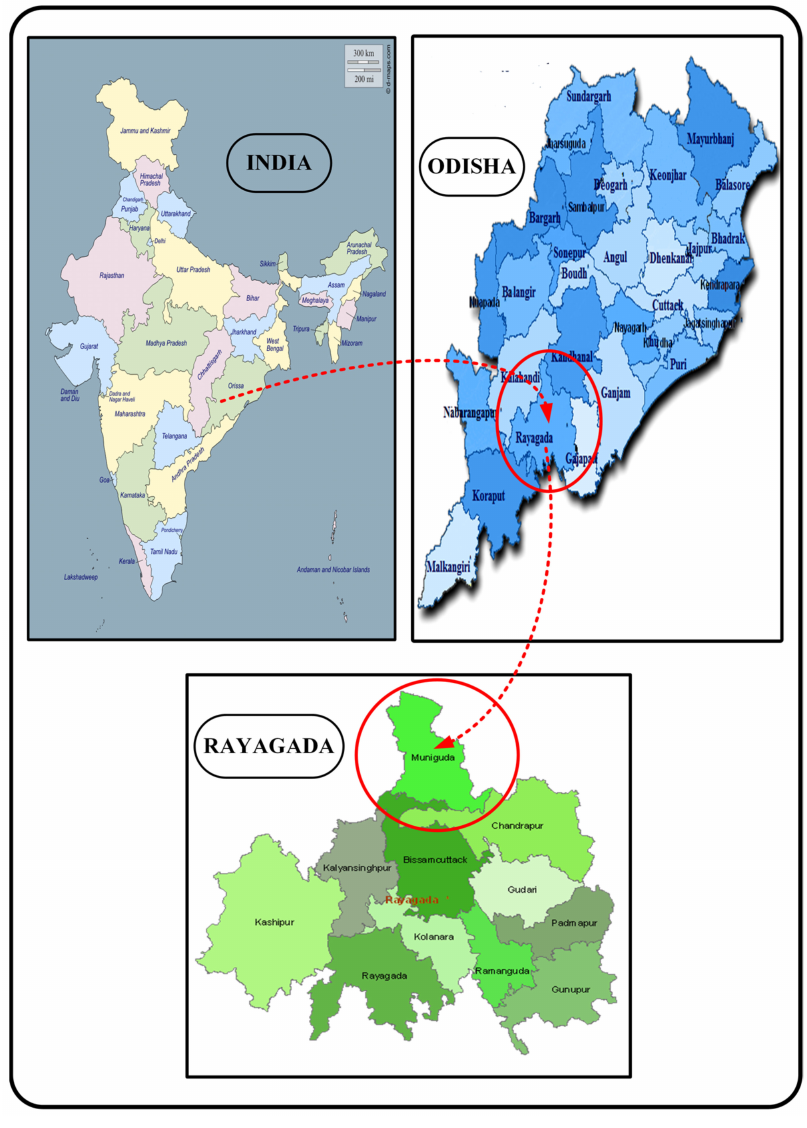
Figure 2. The location of the study area on the